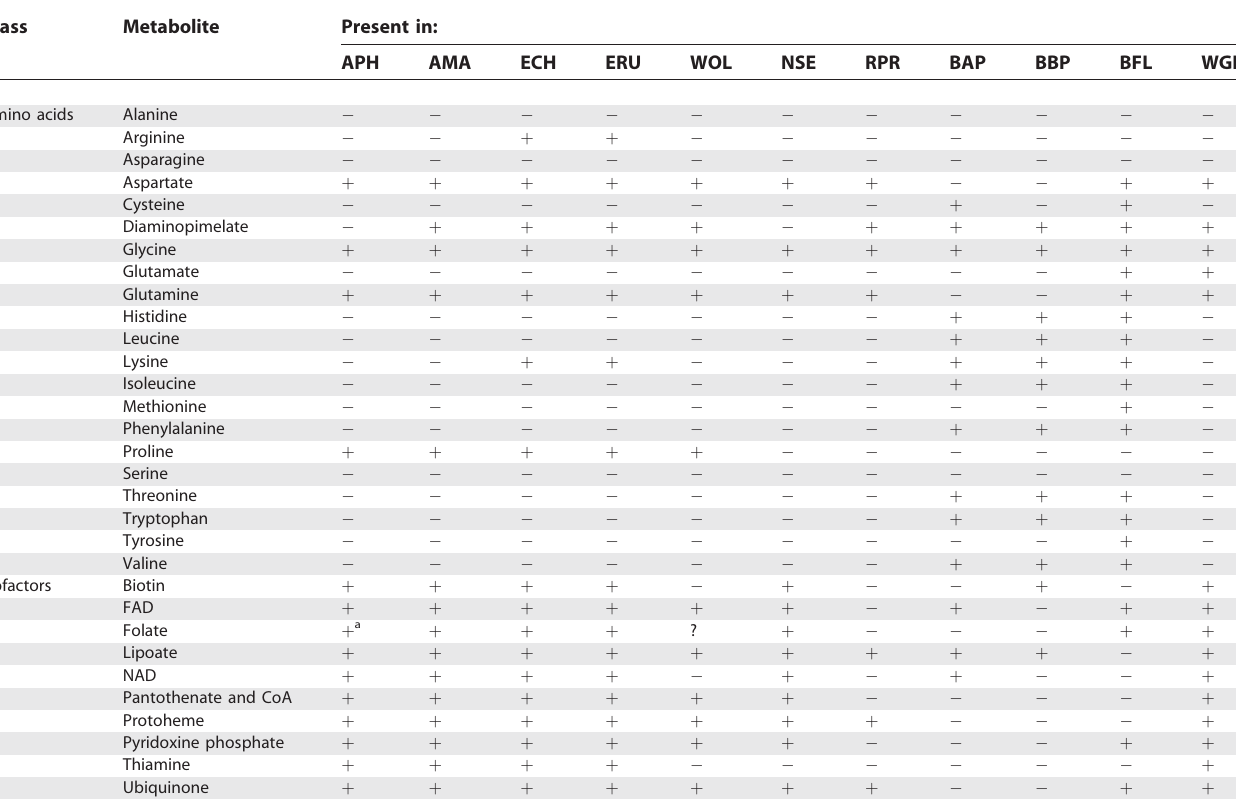
Table 5. Amino Acid and Cofactor Biosynthesis in Intracellular Bacteria Class Metabolite Present in: